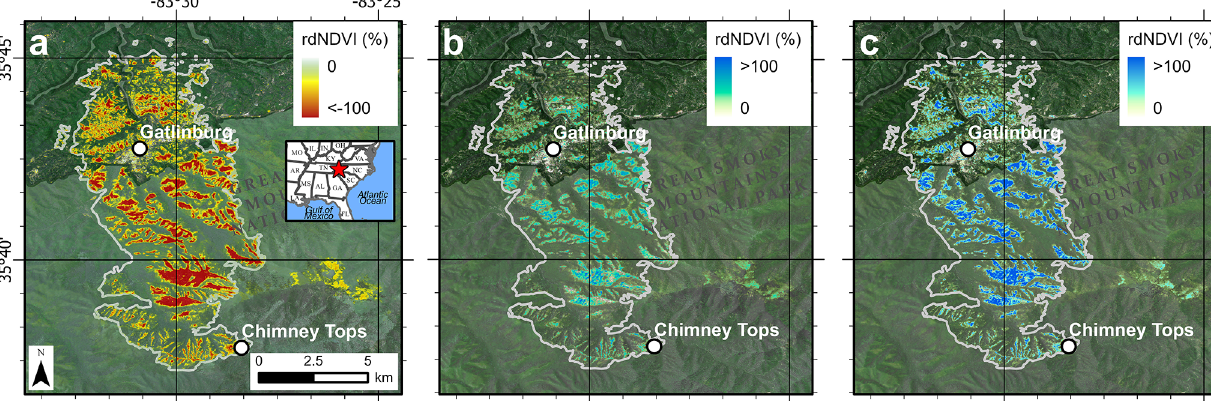
Figure 5. rdNDVI change detection images of vegetation loss and recovery during and following the Chimney Tops 2 fire that impacted Gatlinburg, Tennessee, USA, and surrounding communities in November–December 2016 (see location map to right). (a) rdNDVI illustrates vegetative loss during the fire. Gray line is the 6936ha (17140 acres) published extent of the burn (USGS, 2020). Note the preferential vegetative loss (burn) along ridgetops. Base image is pre-event. Parameters – event date: 13 December 2016; pre-window: 12 months; post-window: 9 months. (b) Change detection image of rdNDVI illustrating vegetative recovery between the first (2017) and second (2018) growing seasons following the fire. Base image is post-event. Parameters – event date: 13 December 2017; pre-window: 12 months; post- window: 12 months. (c) Vegetative recovery (rdNDVI) between the first (2017) and third (2019) growing seasons following the fire. Note the general pattern of continuation and expansion of re-greening of the landscape, indicated by generally higher rdNDVI values (blues). Base image is post-event. Parameters – event date: 13 December 2017; pre-window: 12 months; post-window: 24 months. For all panels – dataset: Sentinel-2; maximum cloud cover: 30%; slope threshold: 0 ◦ . rdNDVI and greenest-pixel composite data exported from HazMapper, available from https://go.ncsu.edu/hazmapper-chimneytops (last access: 29 April